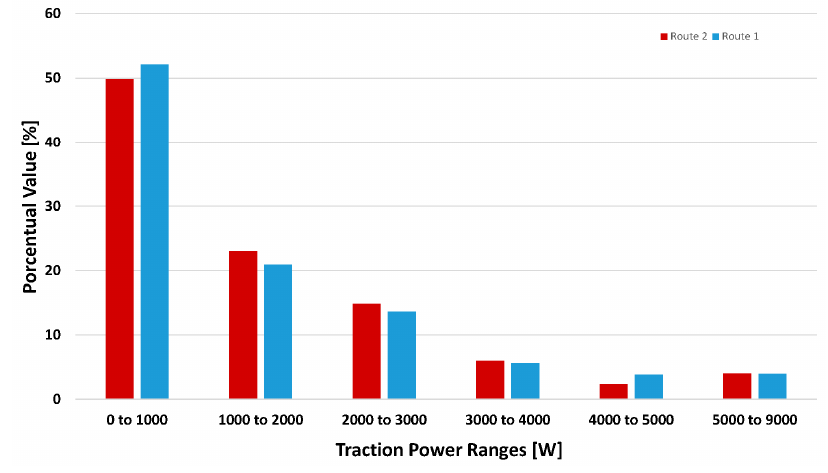
Figure 7. Frequency of instantaneous powers for route 1 (red) and 2 (blue).